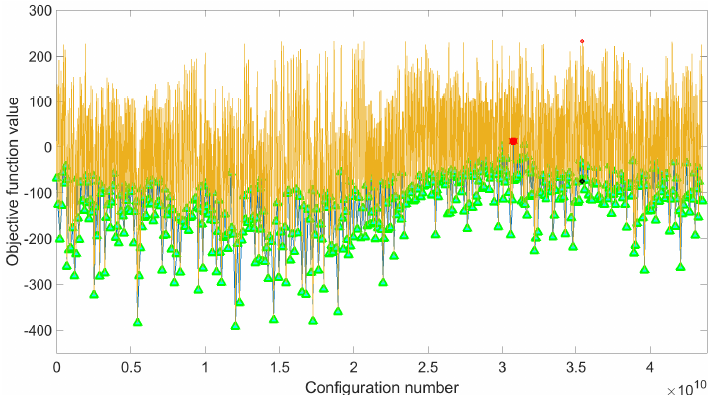
Figure 9. Example of the adaLIPO search for the LTE-20 signal test case. Table 2. Linearisation results with the LTE 20 MHz bandwidth signal.